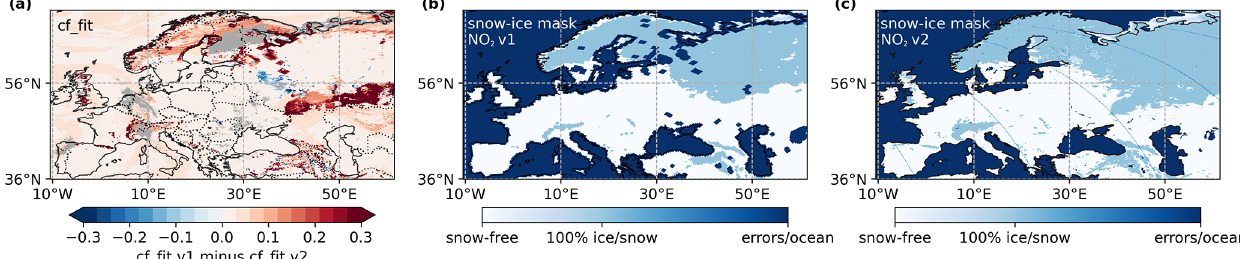
Figure 3. Mapped differences between the cloud fractions from the TROPOMI NO 2 product of versions 1 and 2 for Europe and the spring day (4 April 2019) (a) . Snow and ice mask from the TROPOMI NO 2 product of version 1 (b) and version 2 (c) for Europe and the spring day (4 April 2019). The version 1 map is from the NISE product, and the version 2 map is based on higher spatially and temporally resolved ECMWF